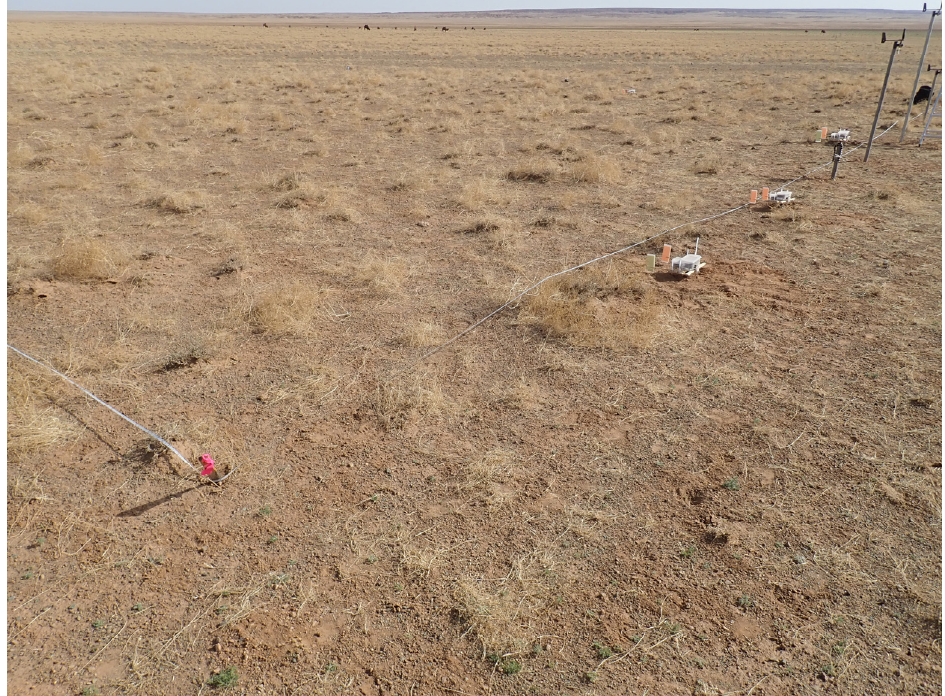
Figure 2. Images of the S. passerina and A. brevifolia community, piezoelectric particle counters, and weather meters. The image shows the site on the north pediment. Small mounds of annual litter are trapped around the shrubs.